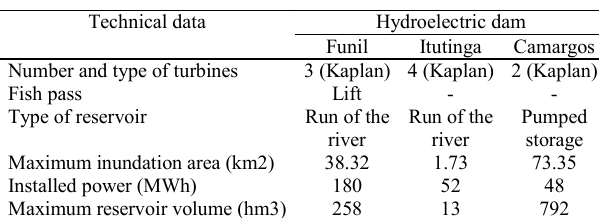
Table 1 . Technical data for the Funil, Itutinga and Camargos hydroelectric power plants located along the upper rio Grande, Minas Gerais, Brazil